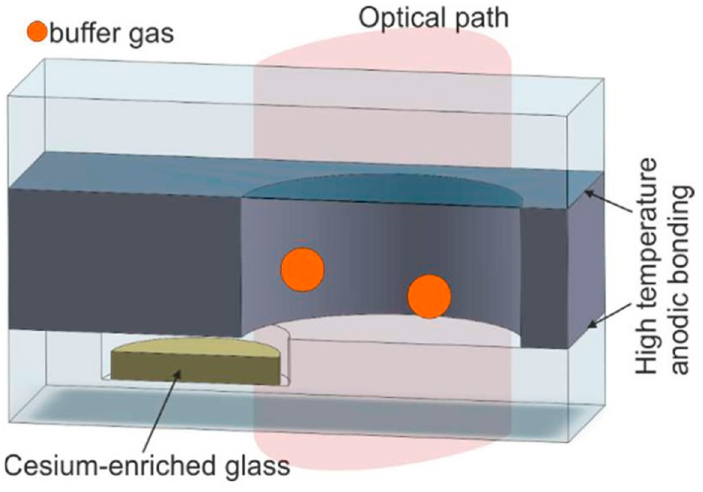
Figure 16. Process flow diagram of atomic vapor cell preparation by electrolysis. Reprinted from ref. [56].